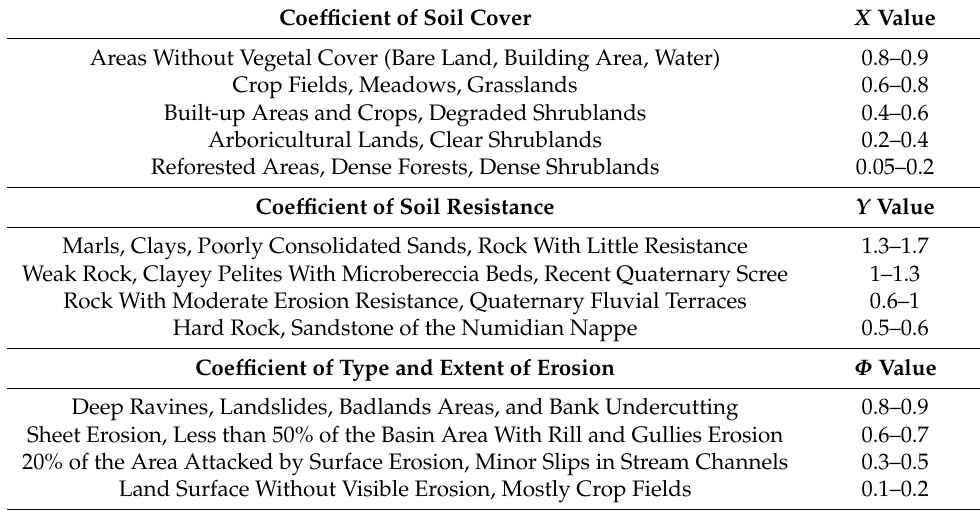
Table 2. Values of the Y, Xa and Φ factors used in the Erosion potential method (EPM)/IntErO model. Coefficient of Soil Cover X Value Areas Without Vegetal Cover (Bare Land, Building Area,